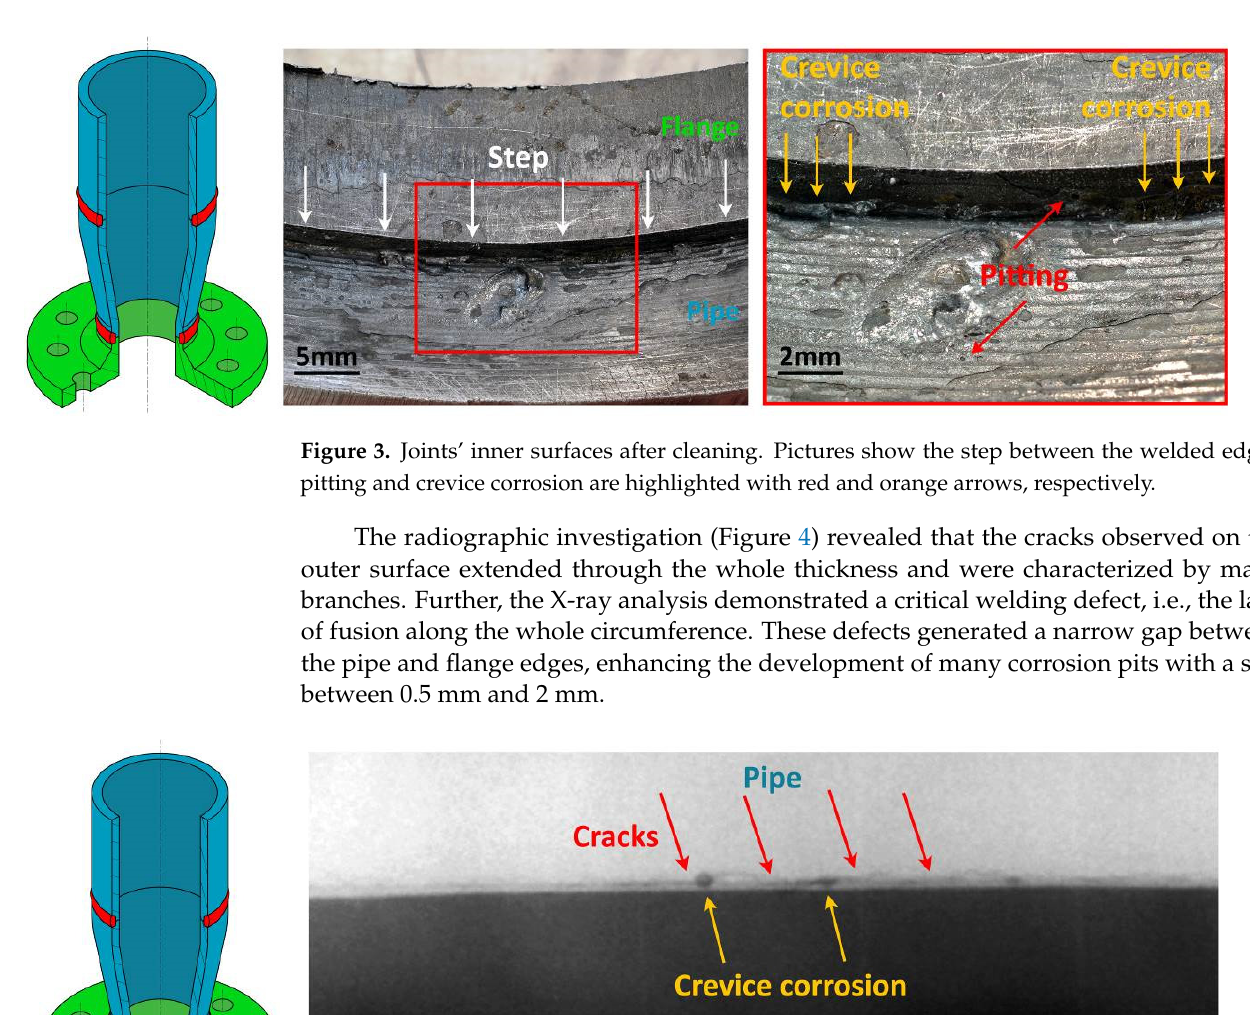
Figure 2. Outer and inner surfaces of the two types of welded joints under investigation. Cracks next to the welding bead are clearly visible in pictures ( a , c ). Pictures ( b , d ) show the lack of fusion and the step in the contact region between the welded parts.